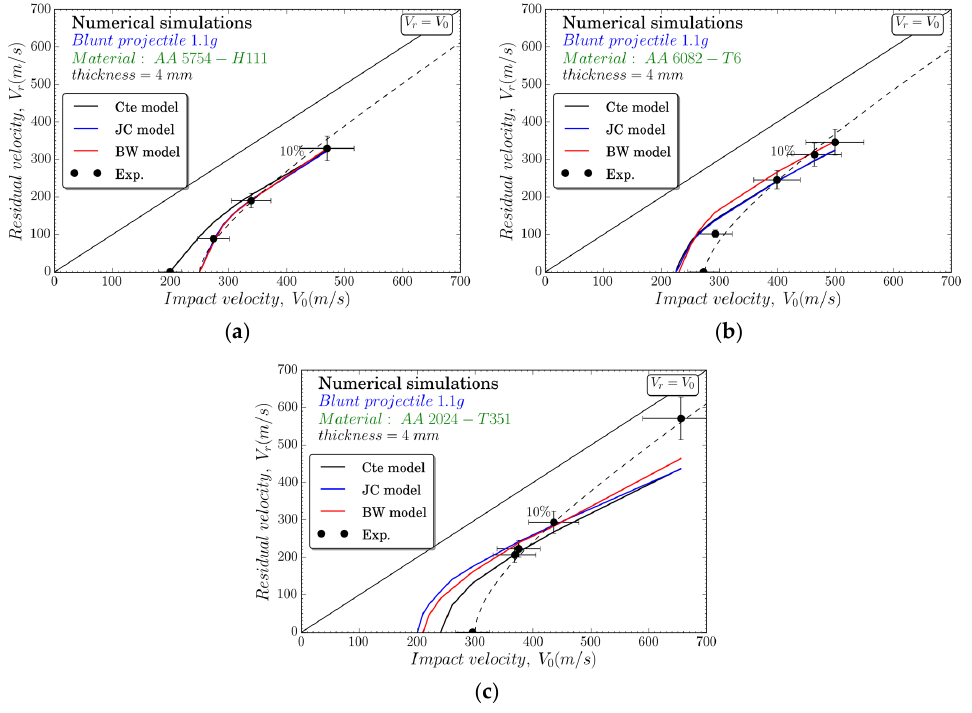
Figure 16. Blunt projectile configuration. Thickness = 4 mm. Comparison of residual velocity V r versus impact velocity V 0 between experiments and numerical simulations for: ( a ) AA 5754 ‐ H111; ( b ) AA 6082 ‐ T6; ( c ) AA 2024 ‐ T351.